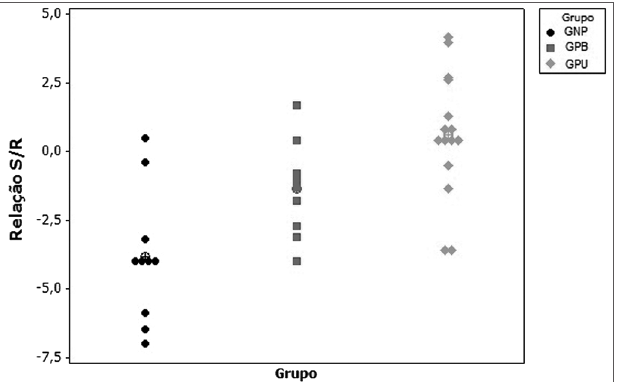
Figura 1. Valores individuais e médios da relação S/R (em dB) no teste LSP de Reconhecimento de Sentenças no Ruído (campo livre) para os três